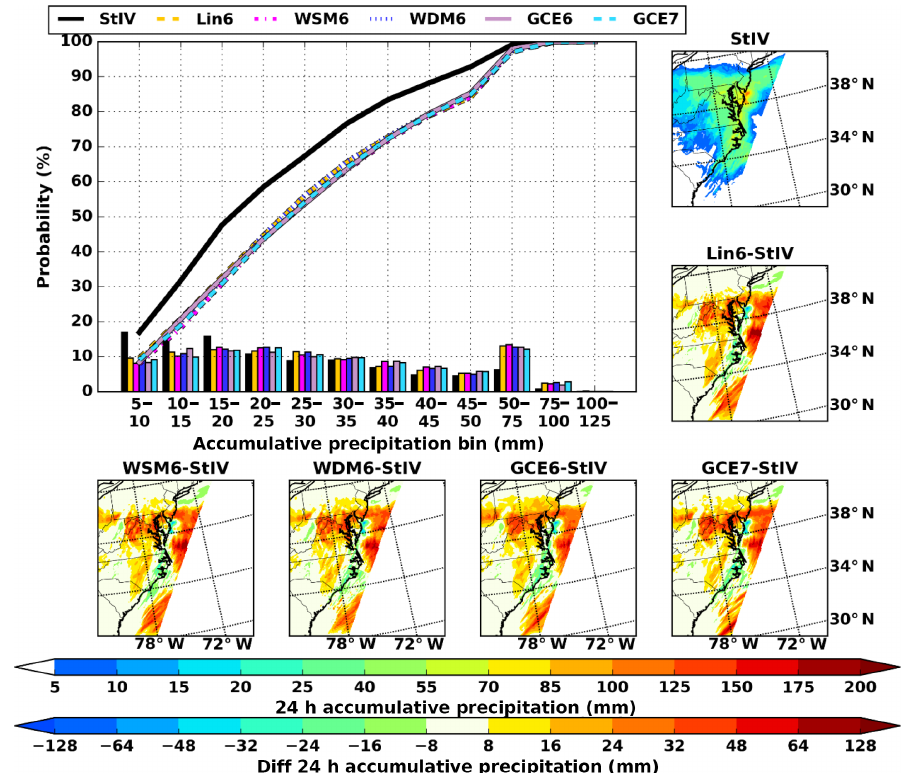
Figure 6. Case 5, 24h precipitation accumulation and their differences (mm, small panels) and corresponding probability density and cu- mulative distribution functions (big panel) of the same data derived from Stage IV and WRF model output. Accumulation period is from 00:00UTC, 6 February 2010–00:00UTC, 7 February 2010. Shown differences are model – Stage IV